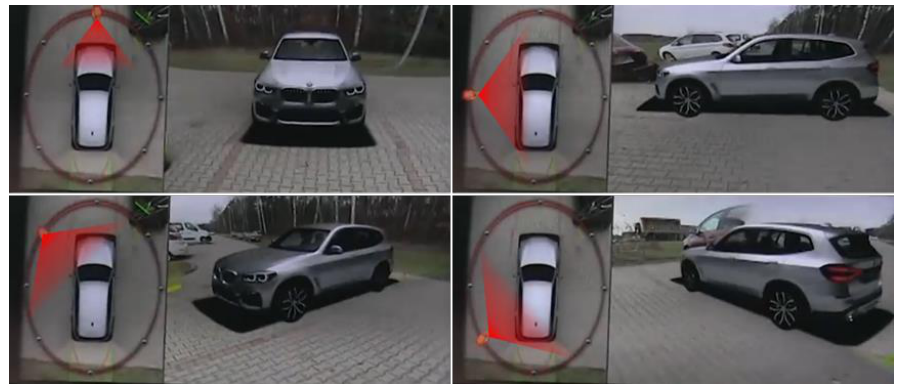
Figure 6. Reconstructed AVM images according to the properties of the virtual AVM camera.